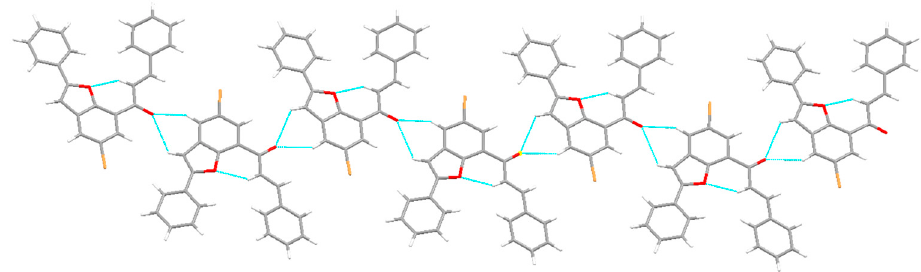
Figure 3. Packing diagram of 3a showing the 1D ribbon.